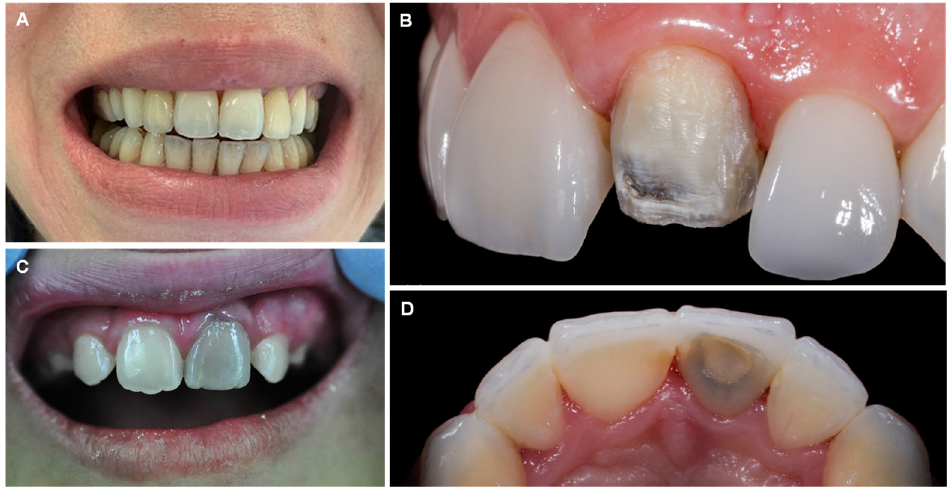
Figure 10. Greyish discoloration of teeth—( A – D ). Reprinted from ( A )—[392], ( B , D )—[393] and ( C )—[394].